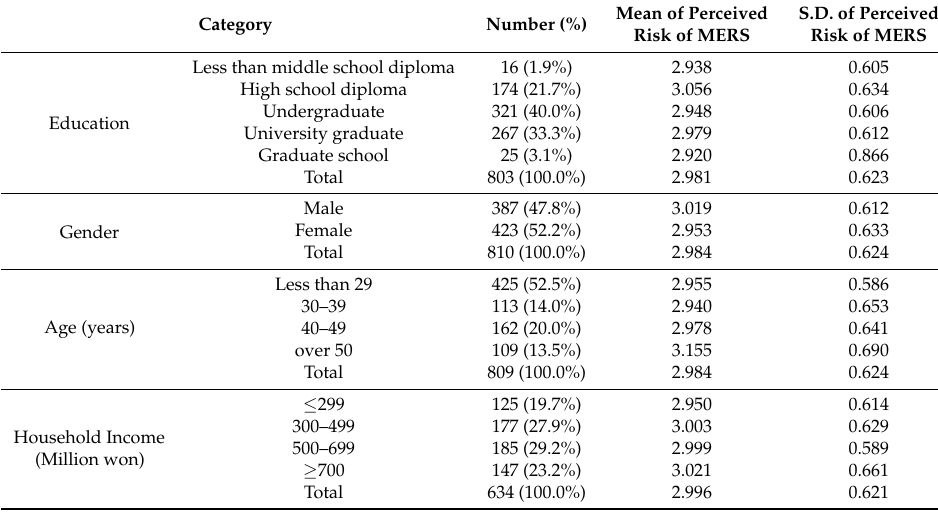
Table 1. Distribution of